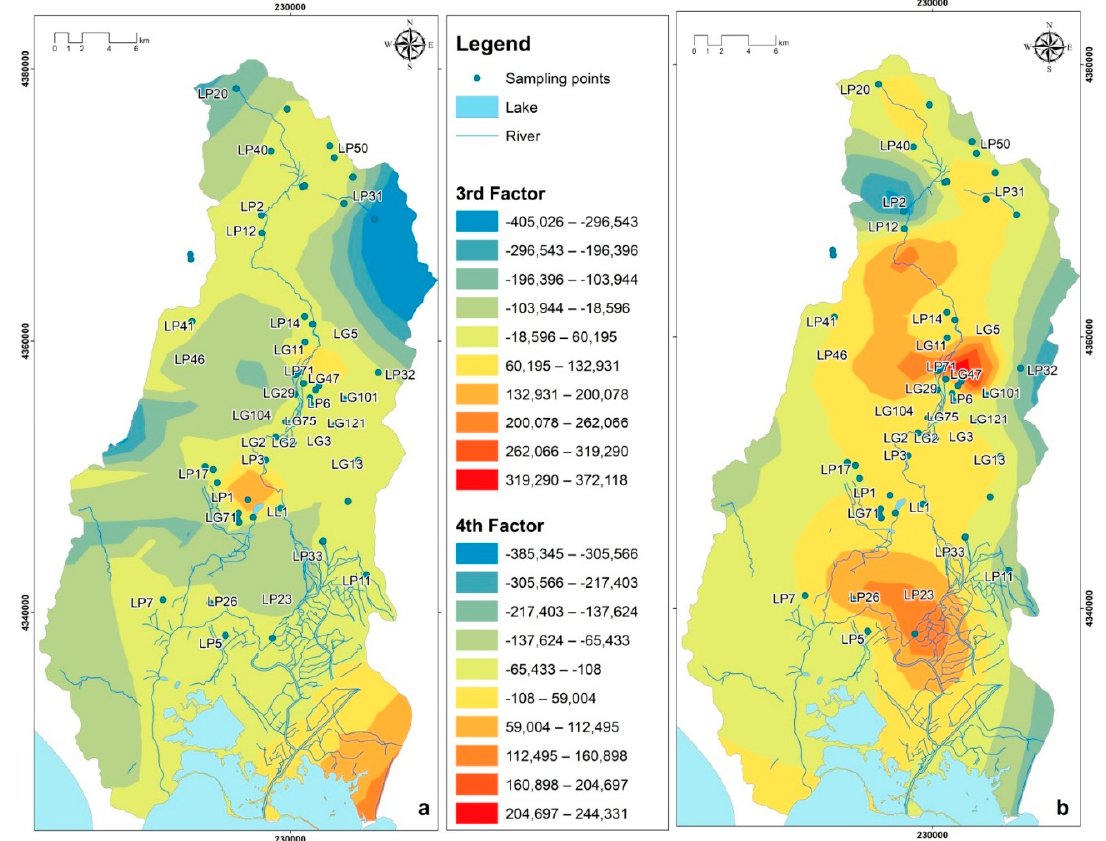
Figure 5. Geographical distribution of a. the third, and b. the fourth factor in Louros Basin.